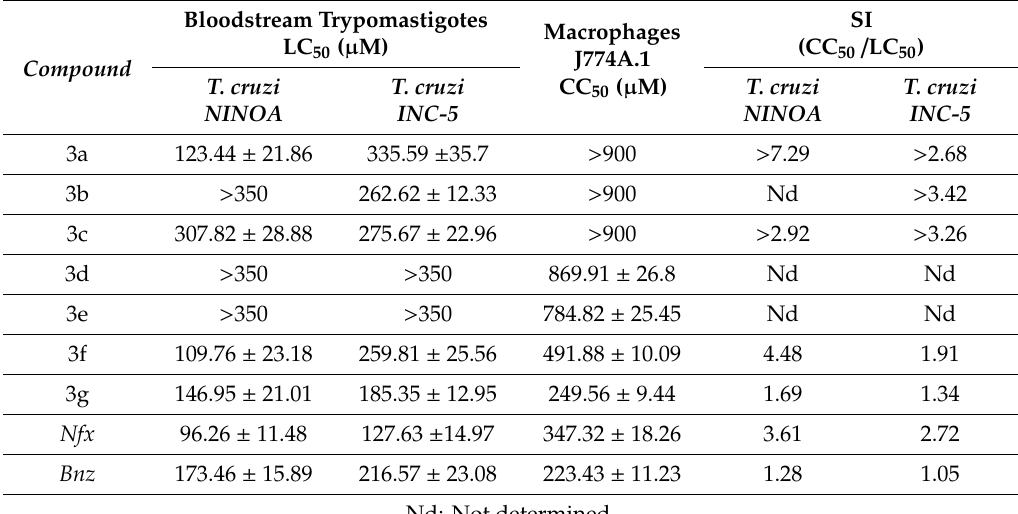
Table 2. Biological activity of BTA derivatives on T. cruzi NINOA and INC-5 strain.